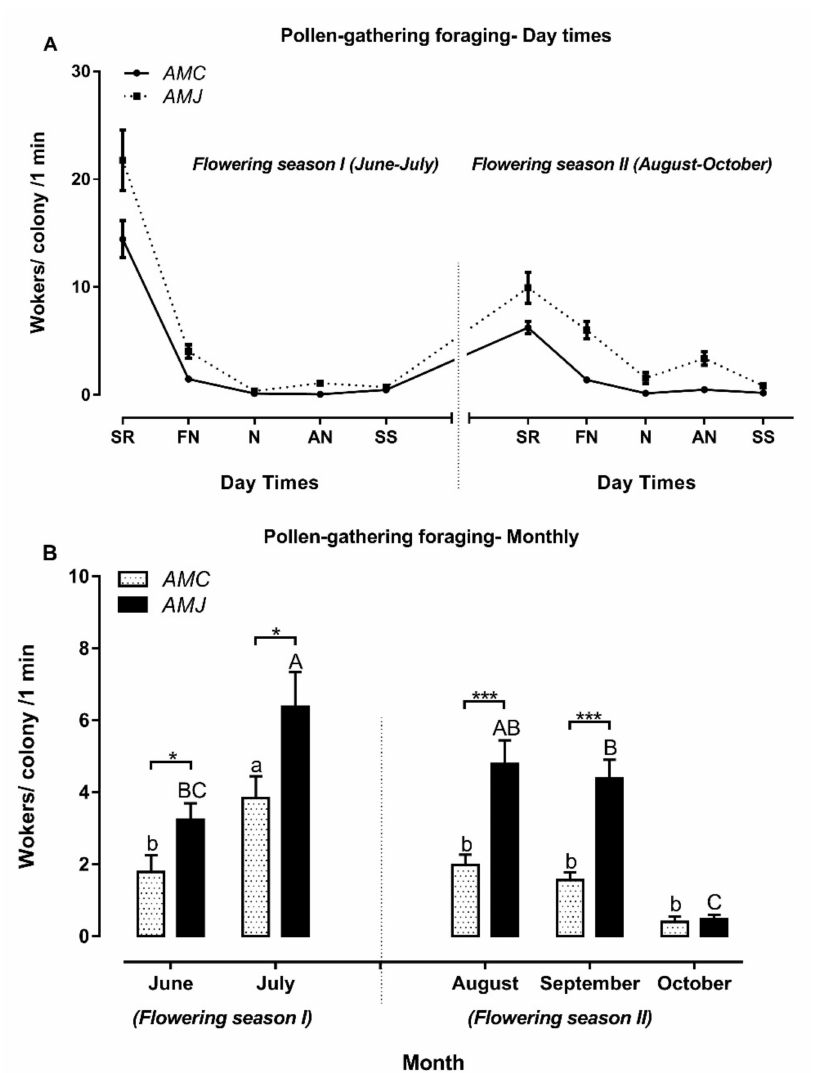
Figure 5. Pollen-gathering activities of the two honey bee subspecies during the two flowering seasons of Z. nummularia in central Arabia. ( A ) Pollen gathering activities (mean ± SEM) of AMJ and AMC recorded at different times of day (SR: sunrise, FN: forenoon, N: noon, AN: afternoon, and SS: sunset). ( B ) Monthly values (mean ± SEM) of the pollen-gathering activities of AMJ and AMC during the two flowering seasons (season I and season II). SEM: standard error of the mean. Flowering season I lasted from June–July, and flowering season II lasted from August–October. Different letters indicate significant differences between the foraging activities of each subspecies given in different columns at p < 0.05. The asterisks indicate significant differences between the two columns in each graph (* p < 0.05; *** p <